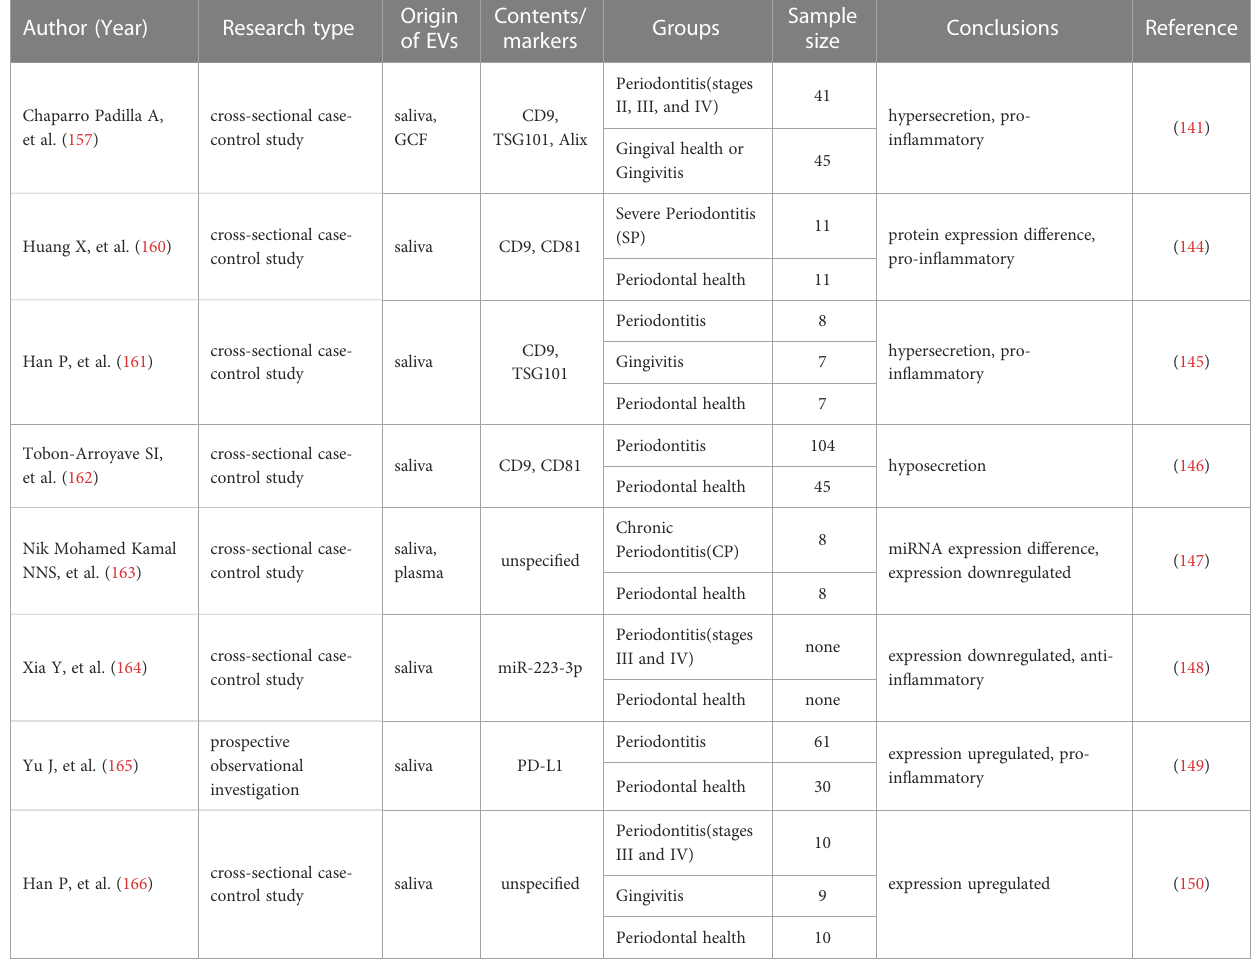
TABLE 1 Application of exosomes in the diagnosis of